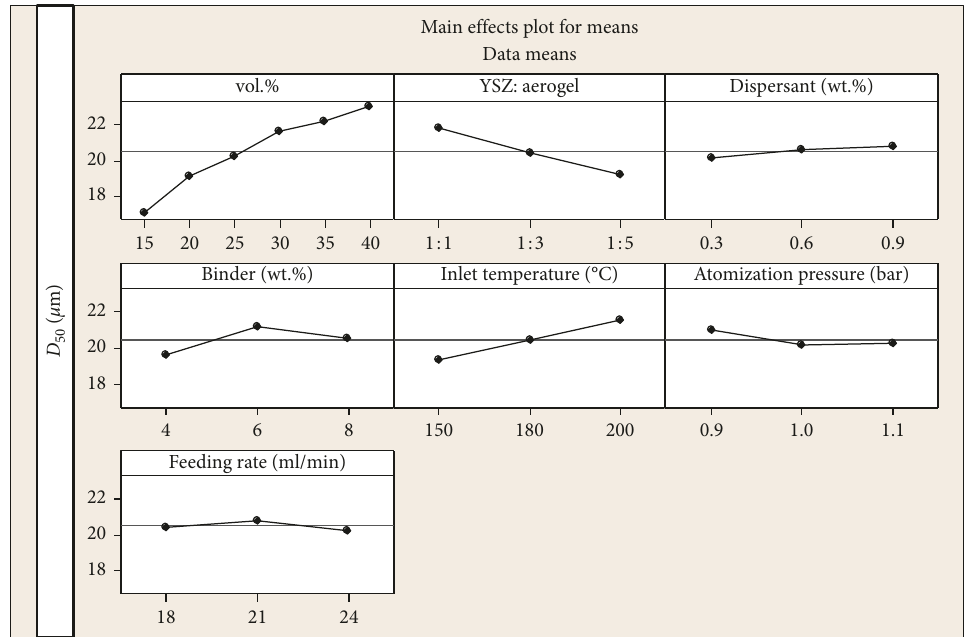
Figure 1: Effect of slurry formulation and granulation variables on median particle size of YSZ-aerogel spray-dried